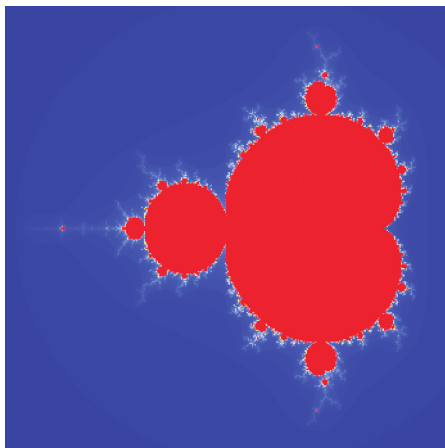
Figure 16: Quadratic Mandelbrot set in JSOmhh.